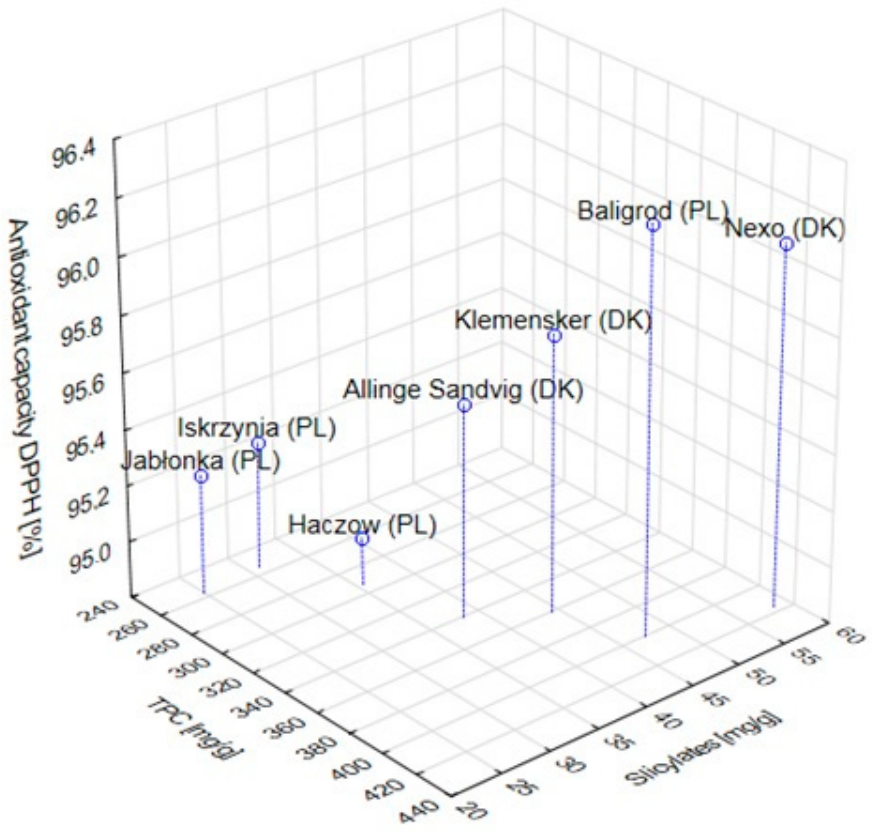
Figure 1. Location of analyzed locations in three-dimensional space.